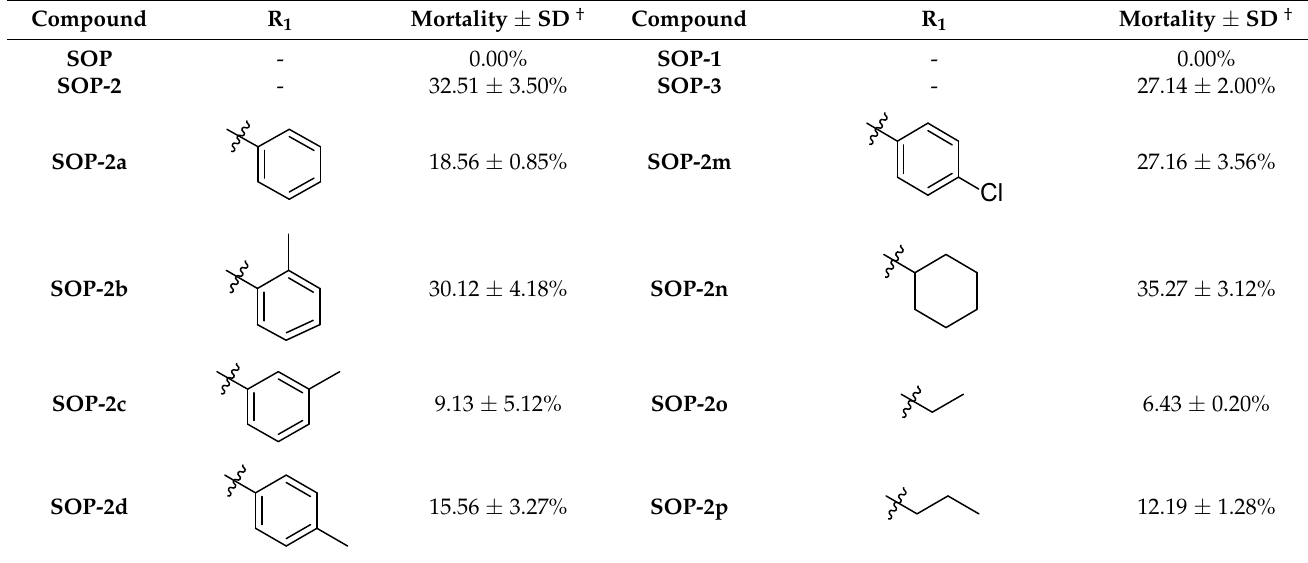
Table 2. Insecticidal activity against female mosquitoes of Ae. albopictus at 0.25 µg/female.